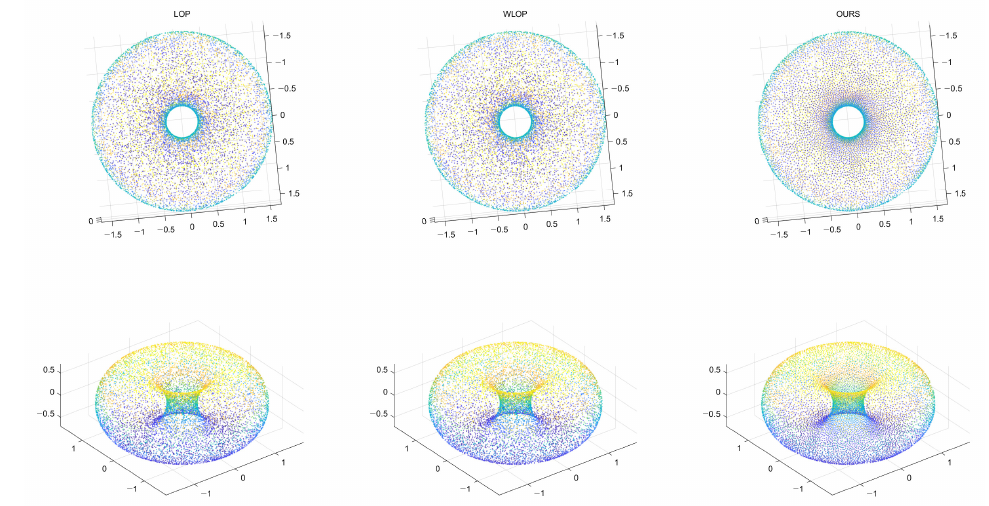
Figure 24. Resampling result of a genus-one shape. Left: LOP, middle: WLOP, and right: pro- posed